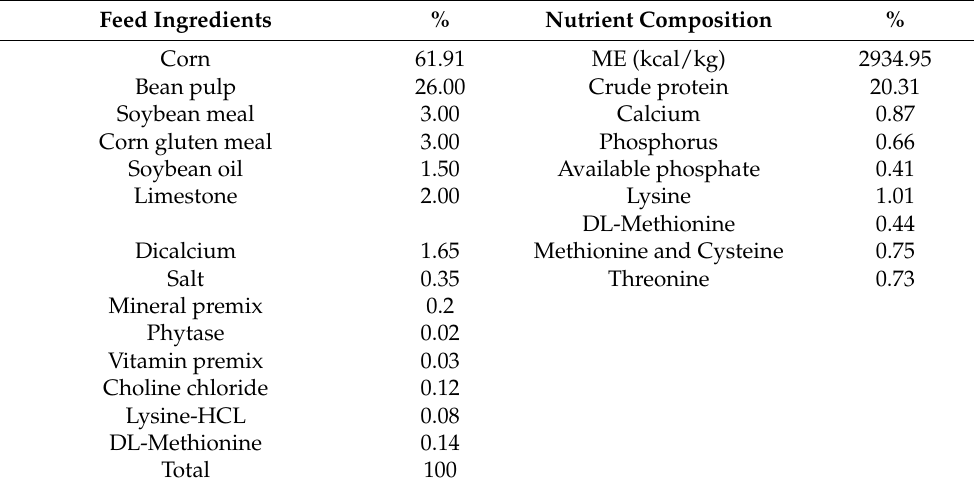
Table 1. Basic diet ingredients and nutritional